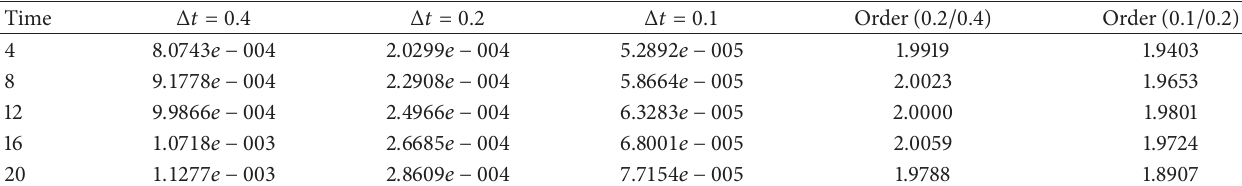
Table 3: Convergence order and error in 𝐿 ∞ norm for 𝑢 of time with ℎ = 0.125 and 𝑐 = 0.1 .